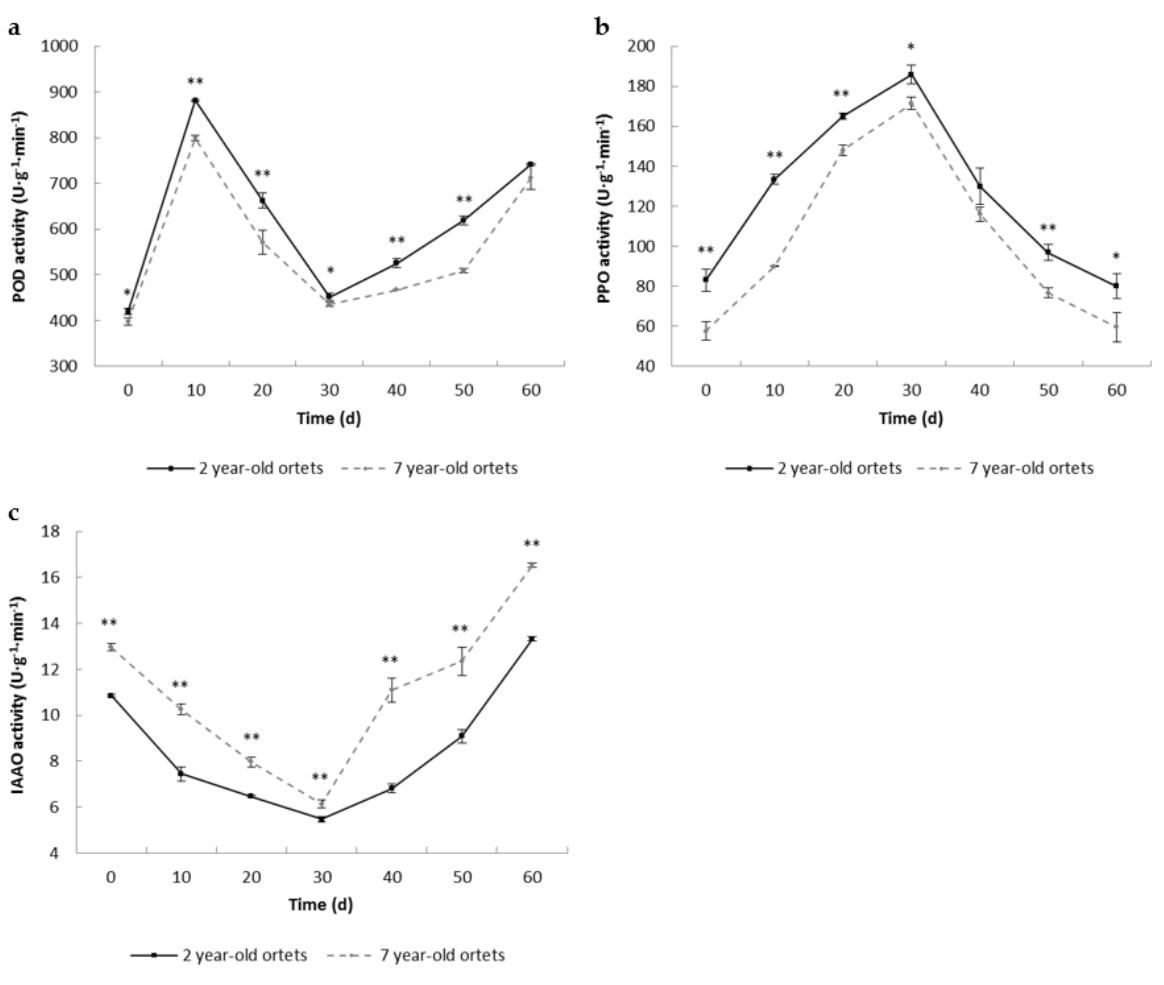
Figure 5. Enzyme activities of cuttings from 2- and 7-year-old ortets during cultivation. ( a ) Peroxi- dase (POD); ( b ) polyphenol oxidase (PPO); ( c ) 3-indoleacetic acid oxidase (IAAO). The unit of en- zyme activity is U • g − 1 • min − 1 , which means 1 μ mol of substrate was converted in 1 min per gram of sample.